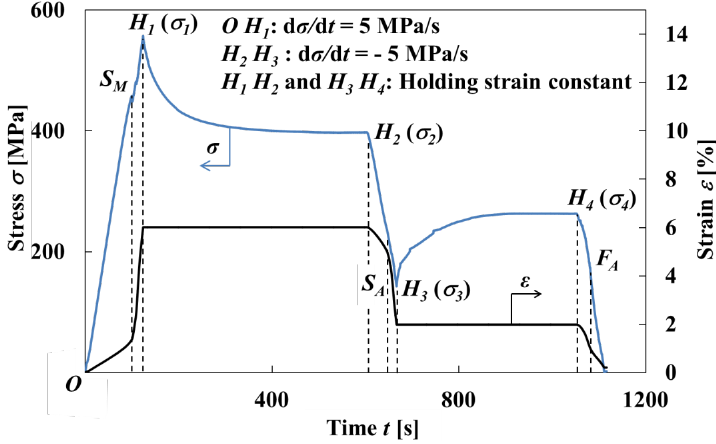
Figure 4. Variation in stress and strain with time obtained by the test under a stress rate of dσ/d t = 5 MPa/s until a point H followed by holding the strain constant until a point H 1 and thereafter unloading until a point H followed by holding the strain constant until a 3 point H 4